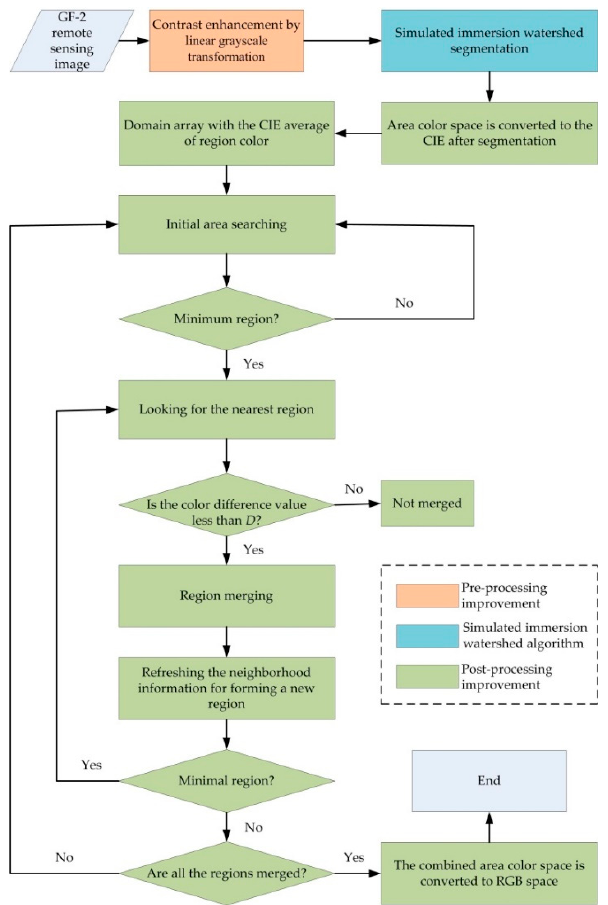
Figure 4. Flowchart of the watershed segmentation algorithm based on Commission Internationale de l´Eclairage (CIE) color space region merging.